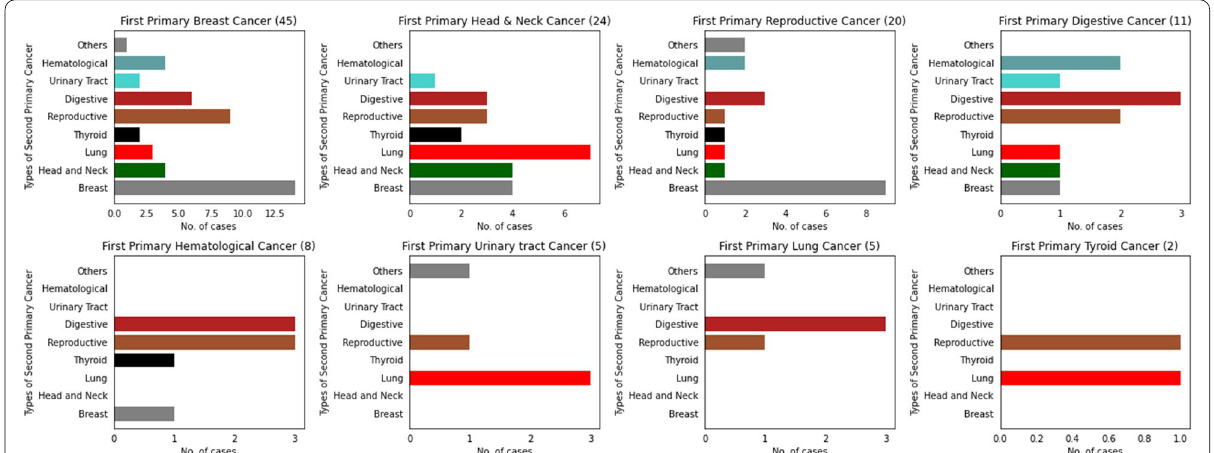
Fig. 3 Graph showing the site-wise distribution of MPMTs in commonly occurring primary cancer sites (*others include bone and soft tissue tumors)